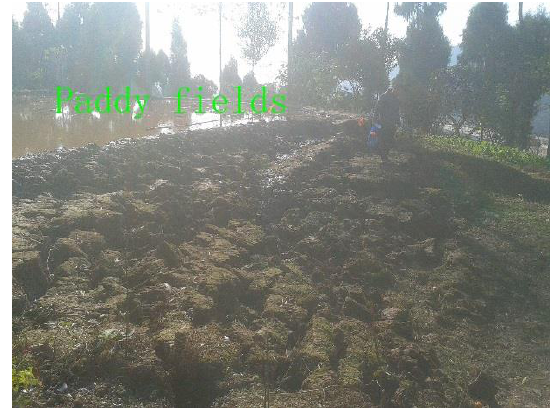
Figure 9. Paddy field in upper landslide.